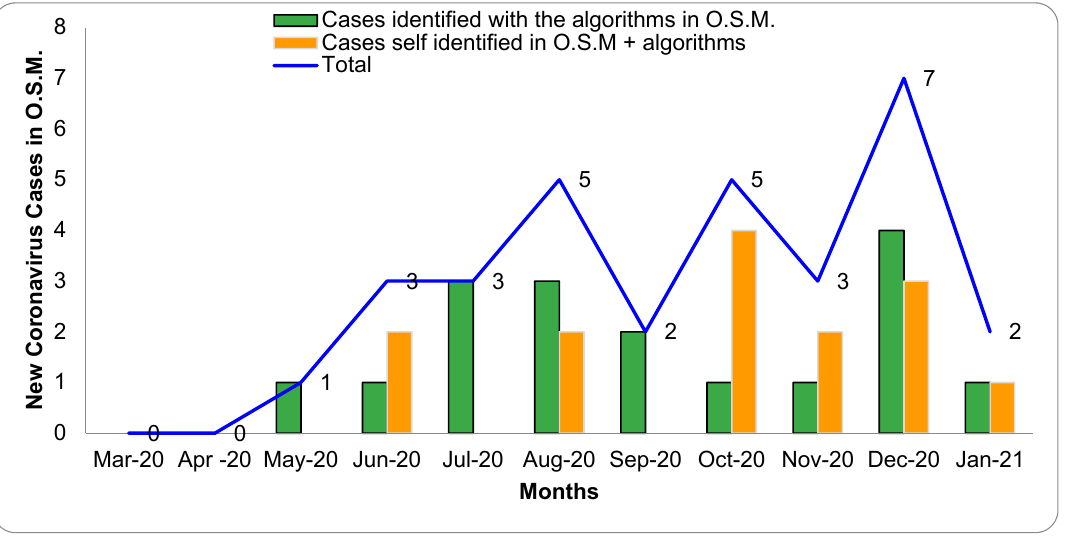
Figure 2. Representation of COVID-19 diagnosed cases in 2020 in the oncology staff members (O.S.M.). This graph shows the number of new cases of COVID-19 per month from March 2020 to January 2021. The employees that were positive with the algorithms (S-Facts and R-Track) are represented by a solid green bar and in a solid orange in bar the self-reported O.S.M. cases (employees with suggestive symptoms for COVID-19 and decide to do PCR test and also respond the algorithms). The blue line represents the total of new COVID-19 cases per month. All the employees with positive algorithm results were confirmed for the SARS-CoV-2 qRT-PCR test.